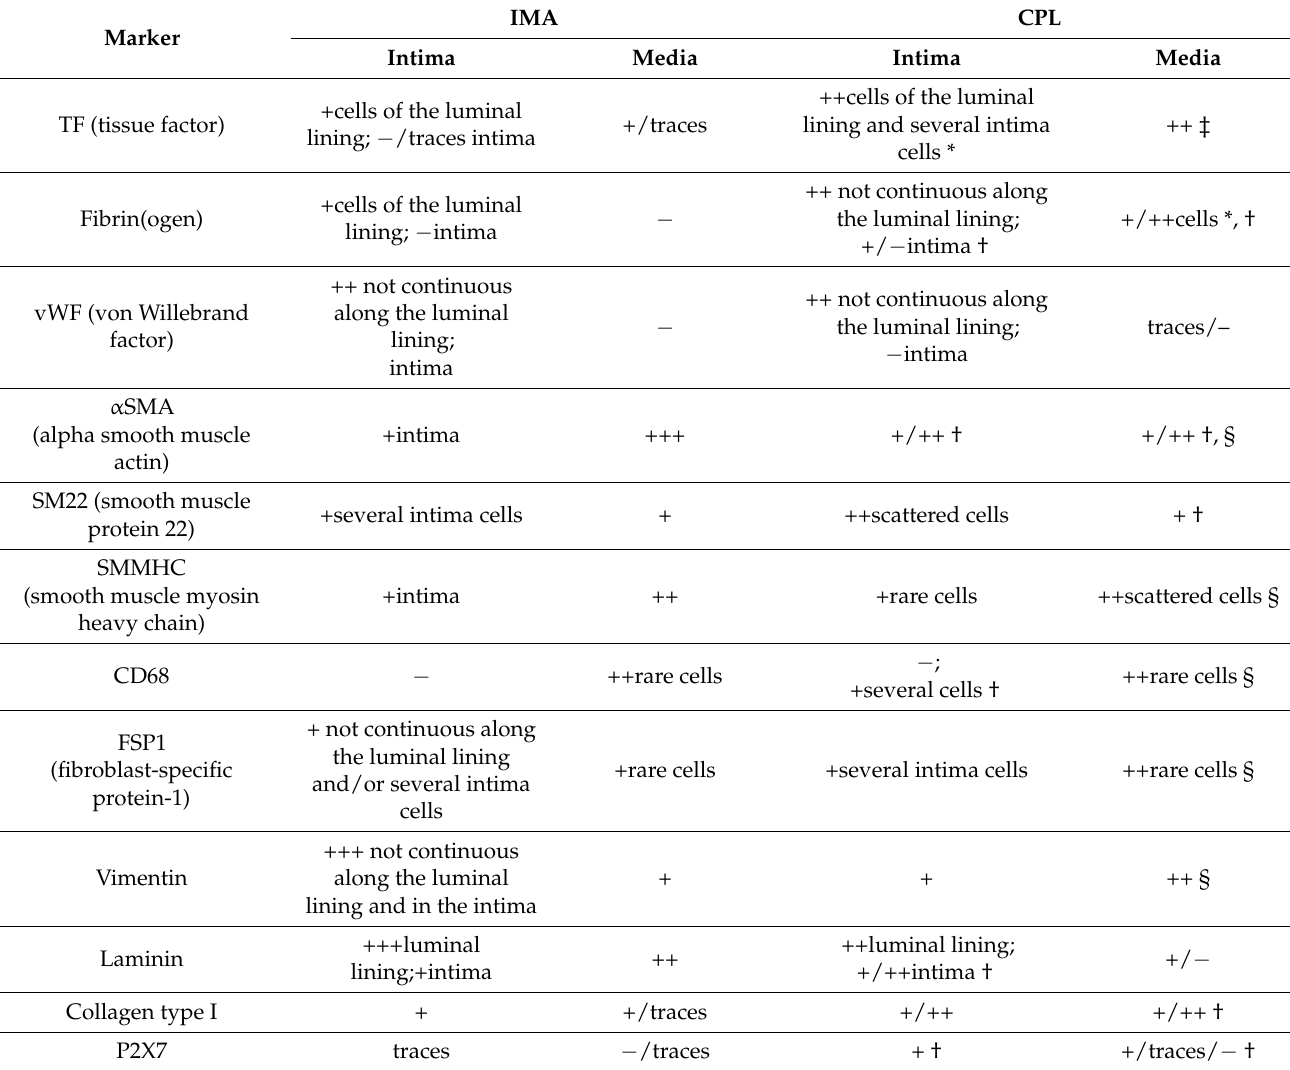
Table 1. Semi-quantitative evaluation by confocal microscopy of markers expression: IMA vs.